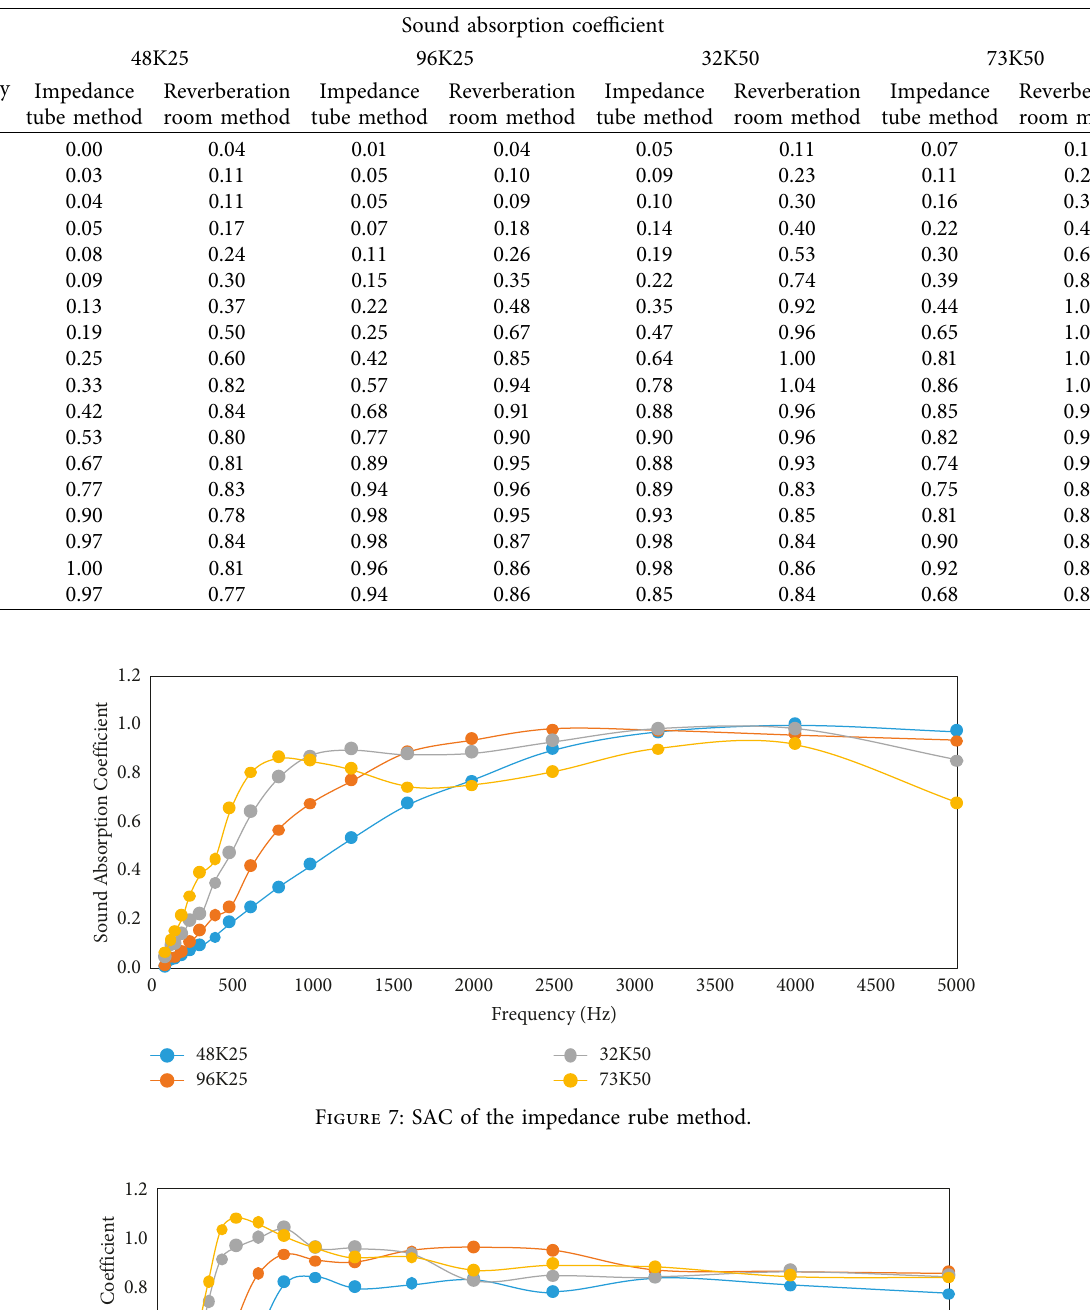
Table 3: SAC measurement results of the impedance tube method and reverberation room method.